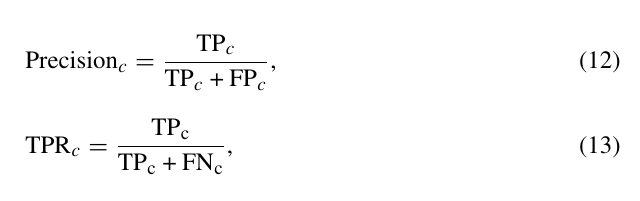
PDRD, c training of models with different layers on Cityscapes, d TE, VE and TA when training on original PDC, (e) TE, VE and TA when training on data augmented